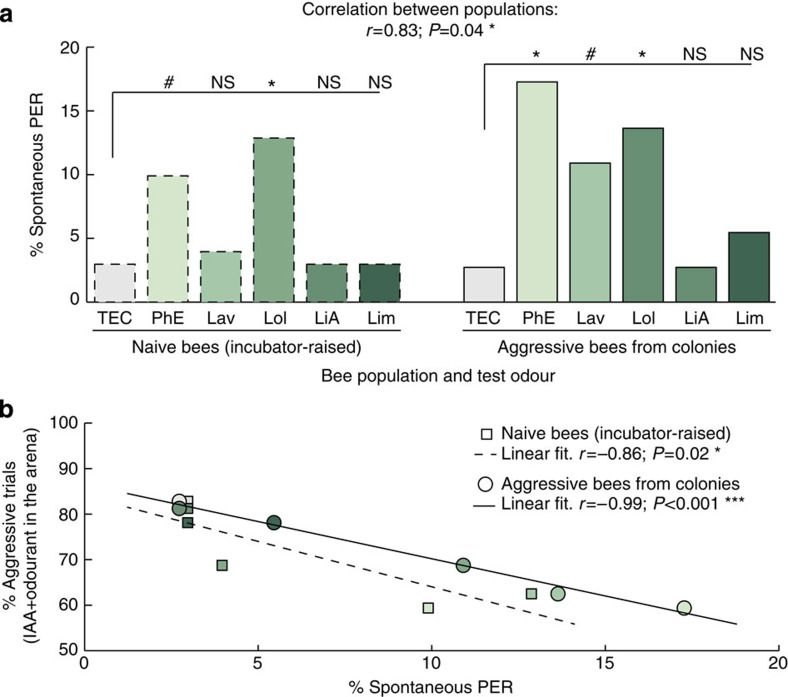
Floral compounds compete with IAA to an extent directly proportional to their appetitive value.(a) Bees participating in the colony defence or naive bees raised in an incubator exhibit spontaneous proboscis extension responses to some floral compounds, in particular to PhE and Lol. McNemar tests, Bonferroni-corrected threshold α=0.01; NS, not significant; P>α, #PhE P=0.020, #Lav P=0.013, *P<α, n=101 naive bees and n=110 aggressive bees. The responses of naive and aggressive bees are correlated. Pearson's r test, r=0.83; P=0.043. (b) The appetitive value of each floral compound correlates with the extent to which it affected the response to IAA during the aggression assays. Pearson's r tests, aggressive bees: r=−0.99, P<0.001; naive bees: r=−0.86, P=0.027.